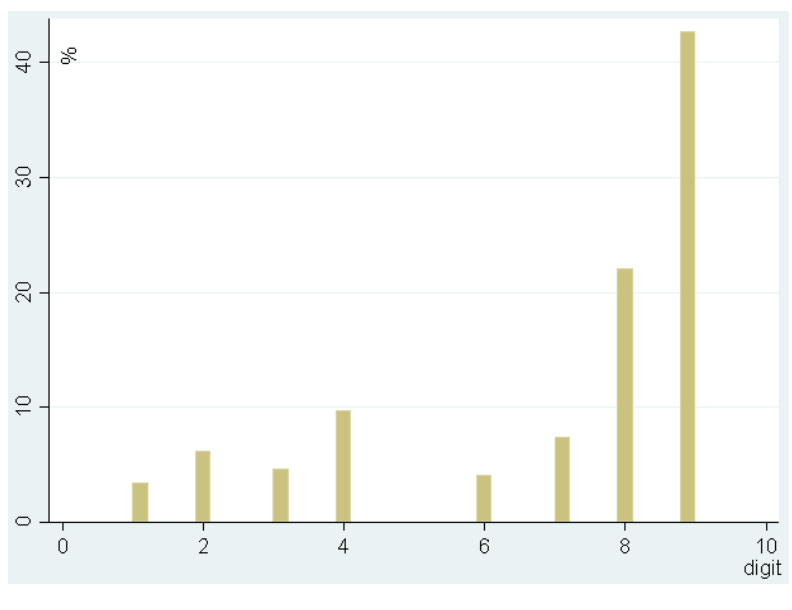
Figure 6. Distribution of sell offers across eight